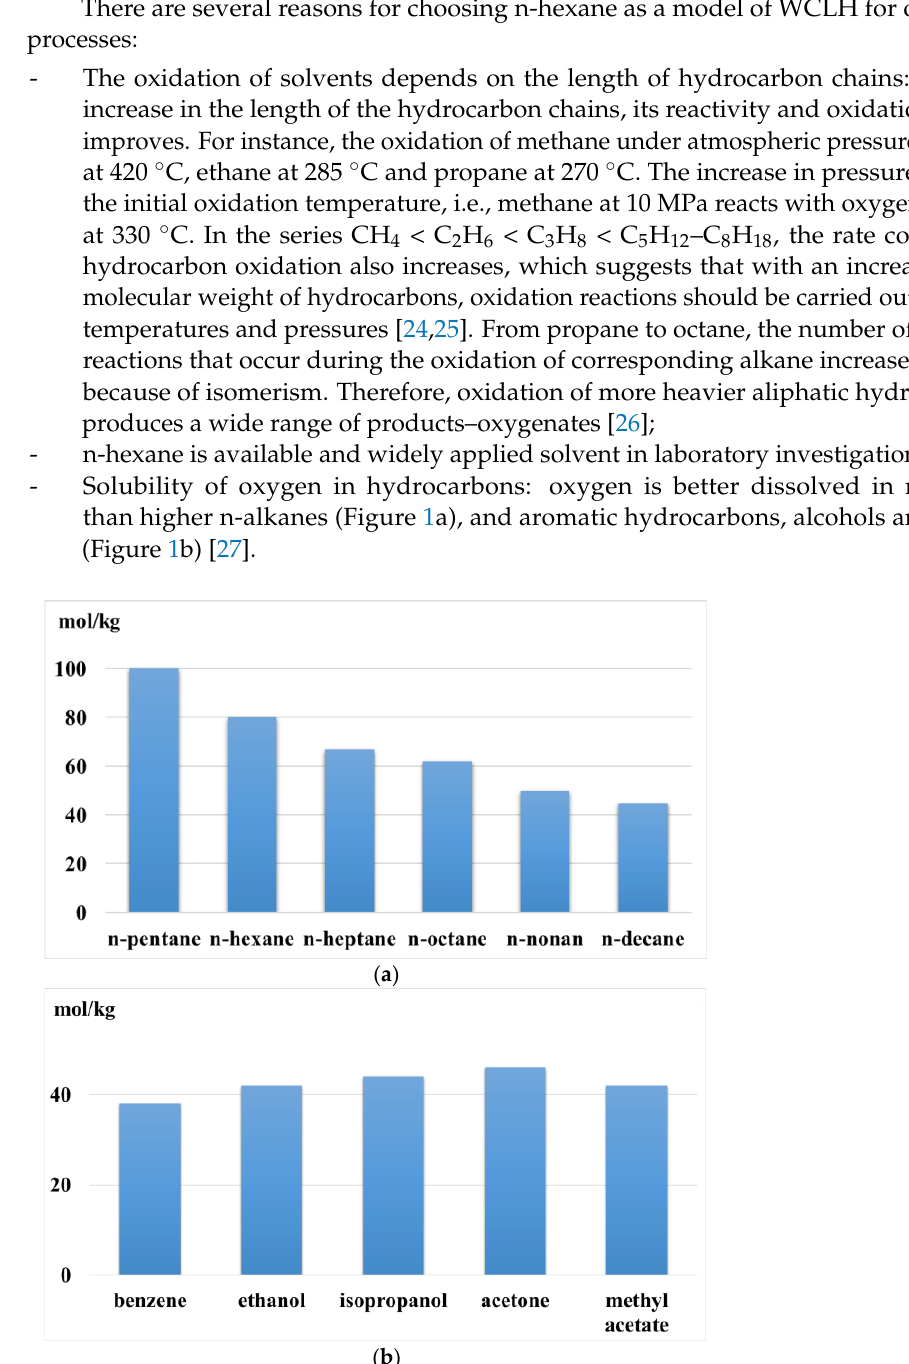
Figure 1. Solubility (mol/kg) of oxygen at 25 °С in n -alkanes ( a , b ) aromatic hydrocarbons, alcohols, ketones and esters.